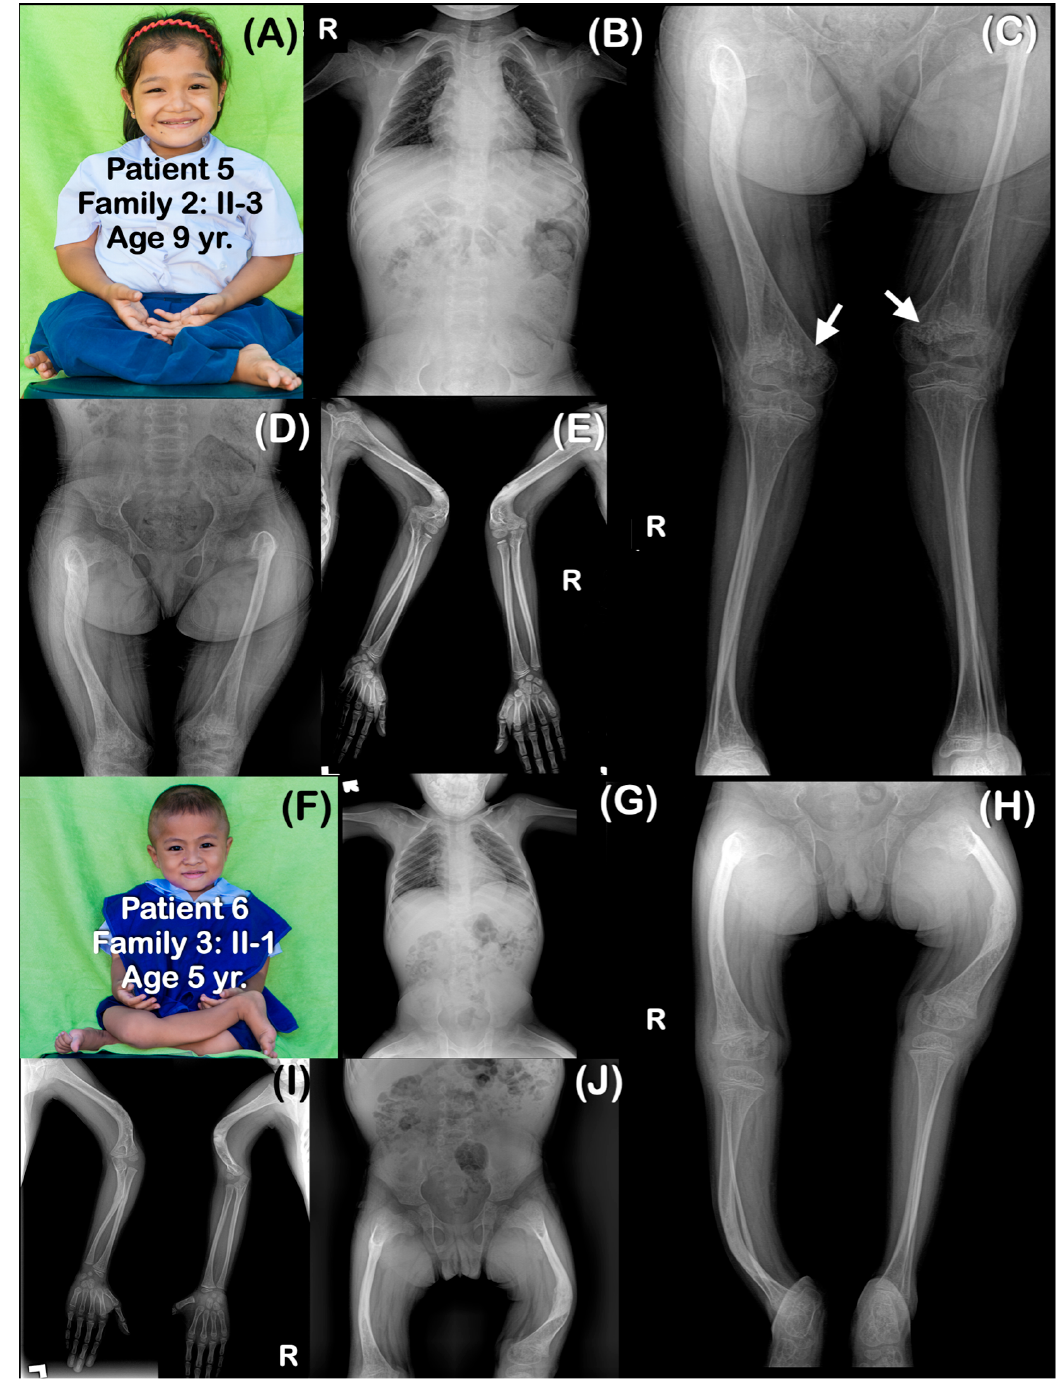
Figure 4. ( A – E ) Family 2. Patient 5 (Family 2: II-3). Age 9 years. The sister of patients 3 and 4. Generalized osteopenia. All long bones are slender. Humeri are shortened and sharply bent distally. Healed greenstick fractures of distal humeri are observed. ( C ) Large metaphyseal flare of femora is noted. Popcorn epiphyses and metaphyses are observed at distal femora (arrows). ( F – H ) Family 3. Patient 6 (Family 3: II-1). Age 5 years. Generalized osteopenia. Absence of trapezium, trapezoid, pisiform, and triquetrum bones bilaterally. All long bones are slender and bowed. Flare of distal femoral metaphyses is noted. Fractures of right humerus, bilateral humeri, and left femur are healed. Popcorn calcifications are not observed.